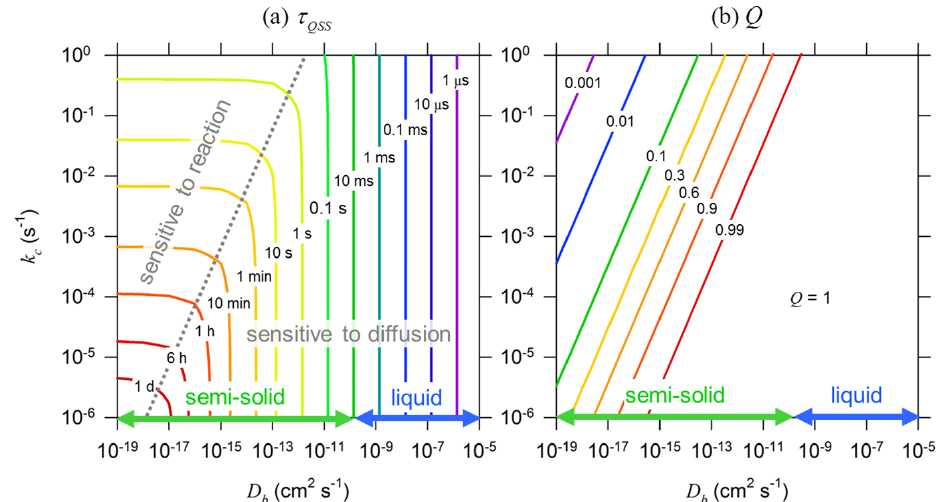
Figure 5. (a) Contour plots of: (a) particle-phase quasi-steady-state timescale ( τ QSS ) , and (b) quasi-steady-state parameter Q = (A/A s ) QSS as functions of first-order rate constant ( k c ) and bulk diffusion coefficient ( D b ) for a species diffusing and reacting within semisolid and liquid particles of diameter D p = 0.1µm.